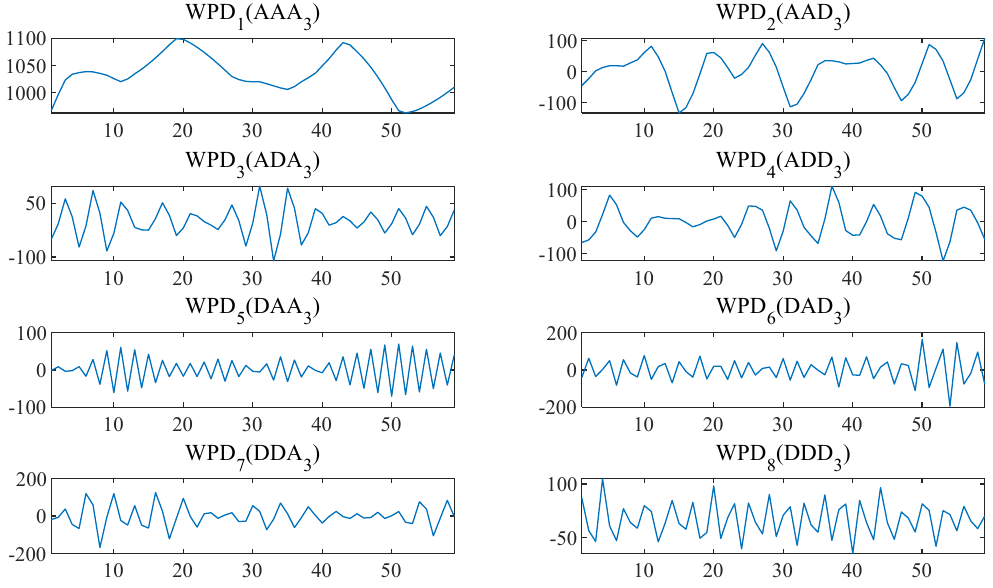
Figure 5. Decomposed results for annual rainfall in Jinsha station.